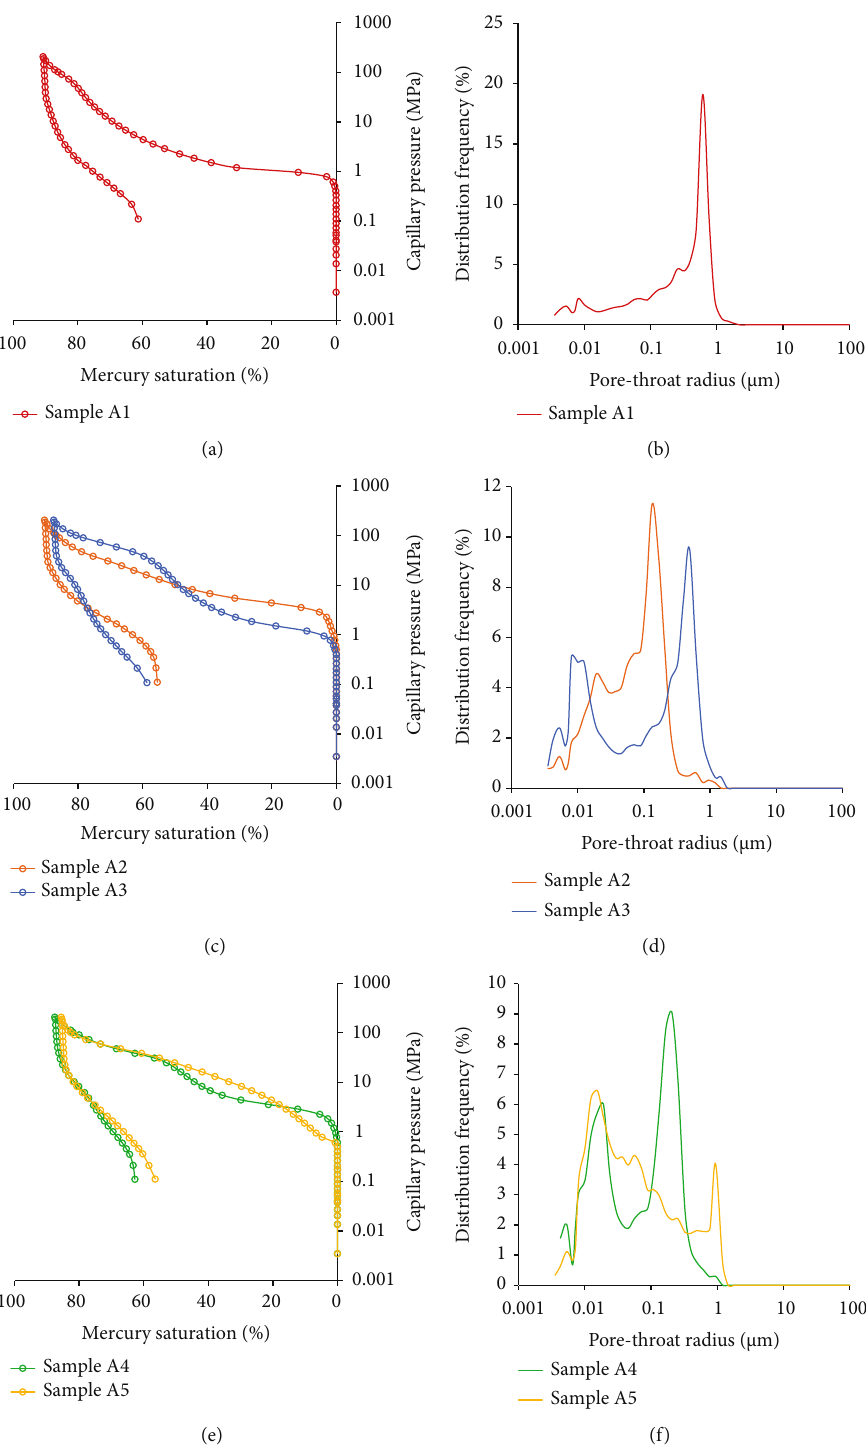
Figure 5: Typical HPMI curves. The capillary pressure curve and distribution curve of pore-throat radius of type I sample (a-b). Type II samples (c-d). Type III samples